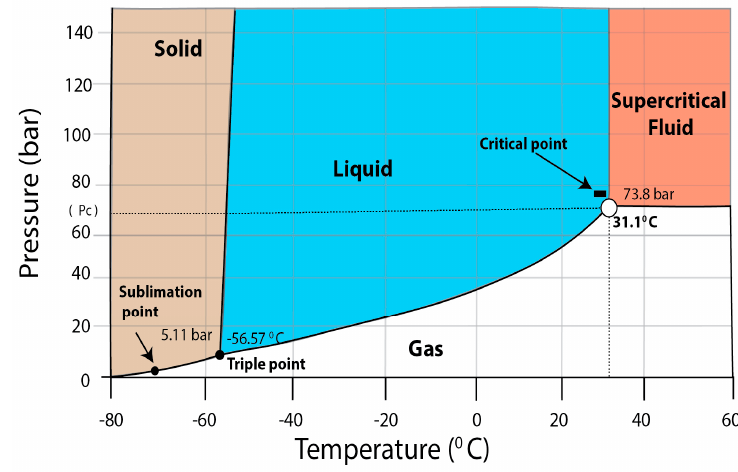
Figure 1. Scheme p-T representation of the CO 2 phase based on Gopaliya et al. [32] with own modifications.